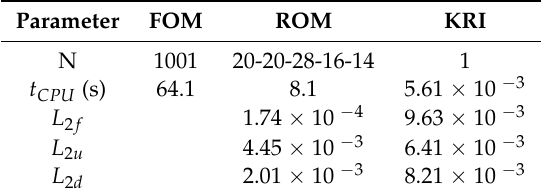
Table 2. FOM, ROM, and KRI (Kriging) comparisons. The designation 20-20-28-16-14refers to the ROM 5 with m = ¯ m = 20 and m a − m ¯ a − m f = 28 − 16 − 14. Notations L 2 f , L 2 u , L 2 d represent the L 2 error for the reaction force at the right-most node, the nodal displacement, and nodal damage vector, respectively. The time in this table indicates the online computation